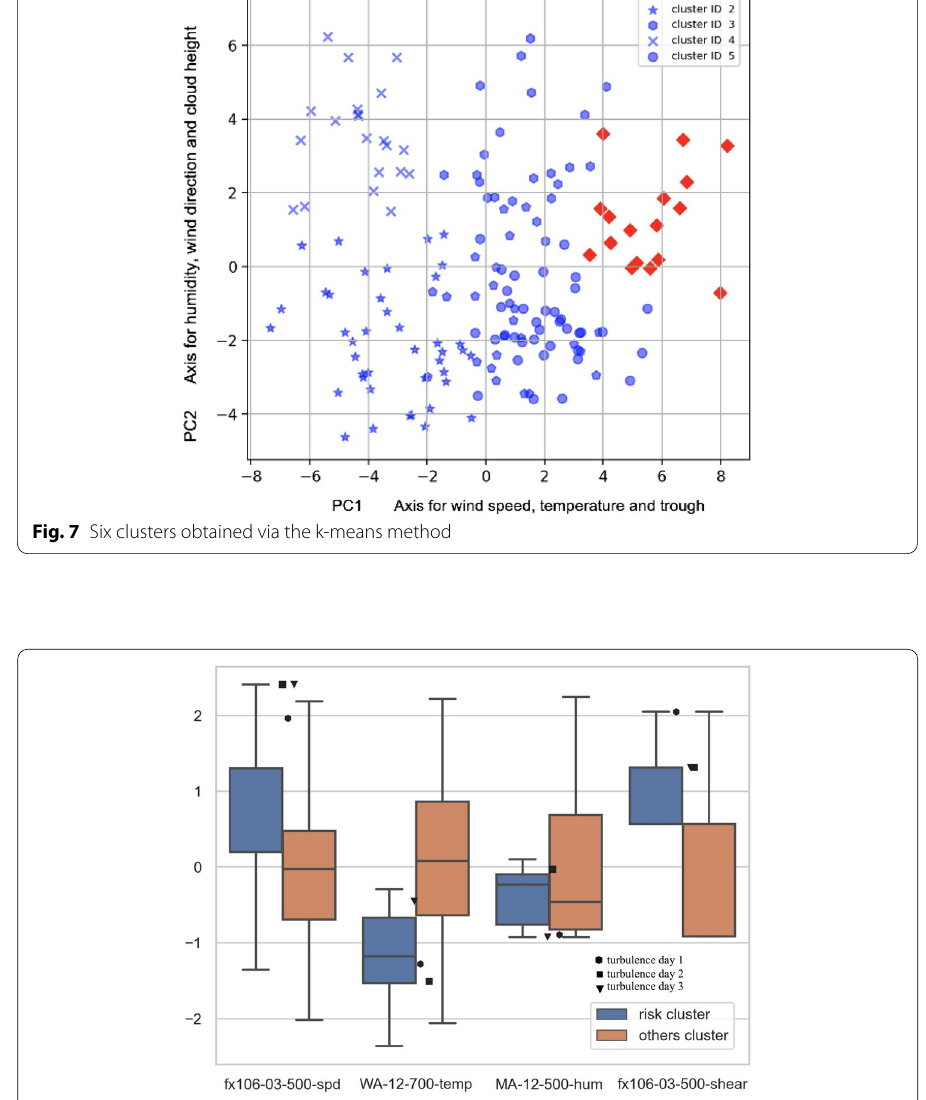
Fig. 8 Comparison of risk cluster and other